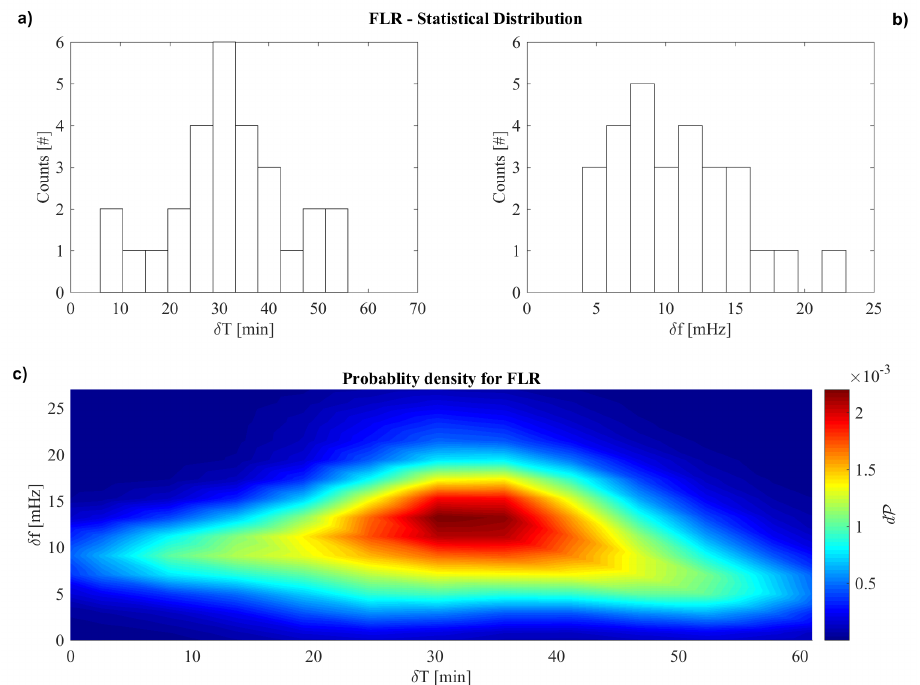
Figure 3. Eigenfrequency variation (panel ( a )) and relative time duration (panel ( b )) data distributions of the FLR. Panel ( c ) shows the probability density distribution of the eigenfrequency variation as a function of the relative time